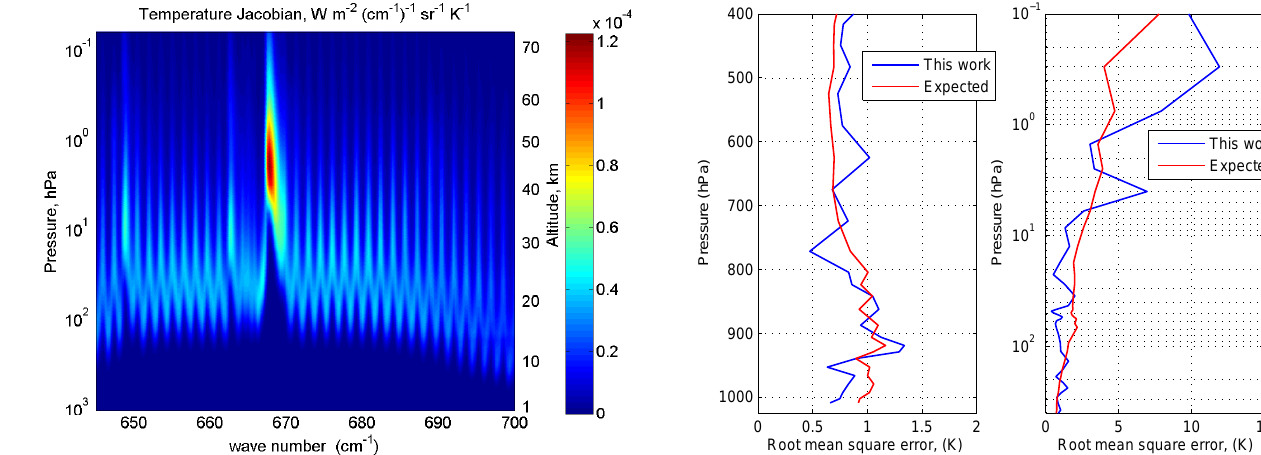
Fig. 9. An example of the radiance derivative (Jacobian) with re- spect to the temperature profile in the range 645 to 700cm − 1 .